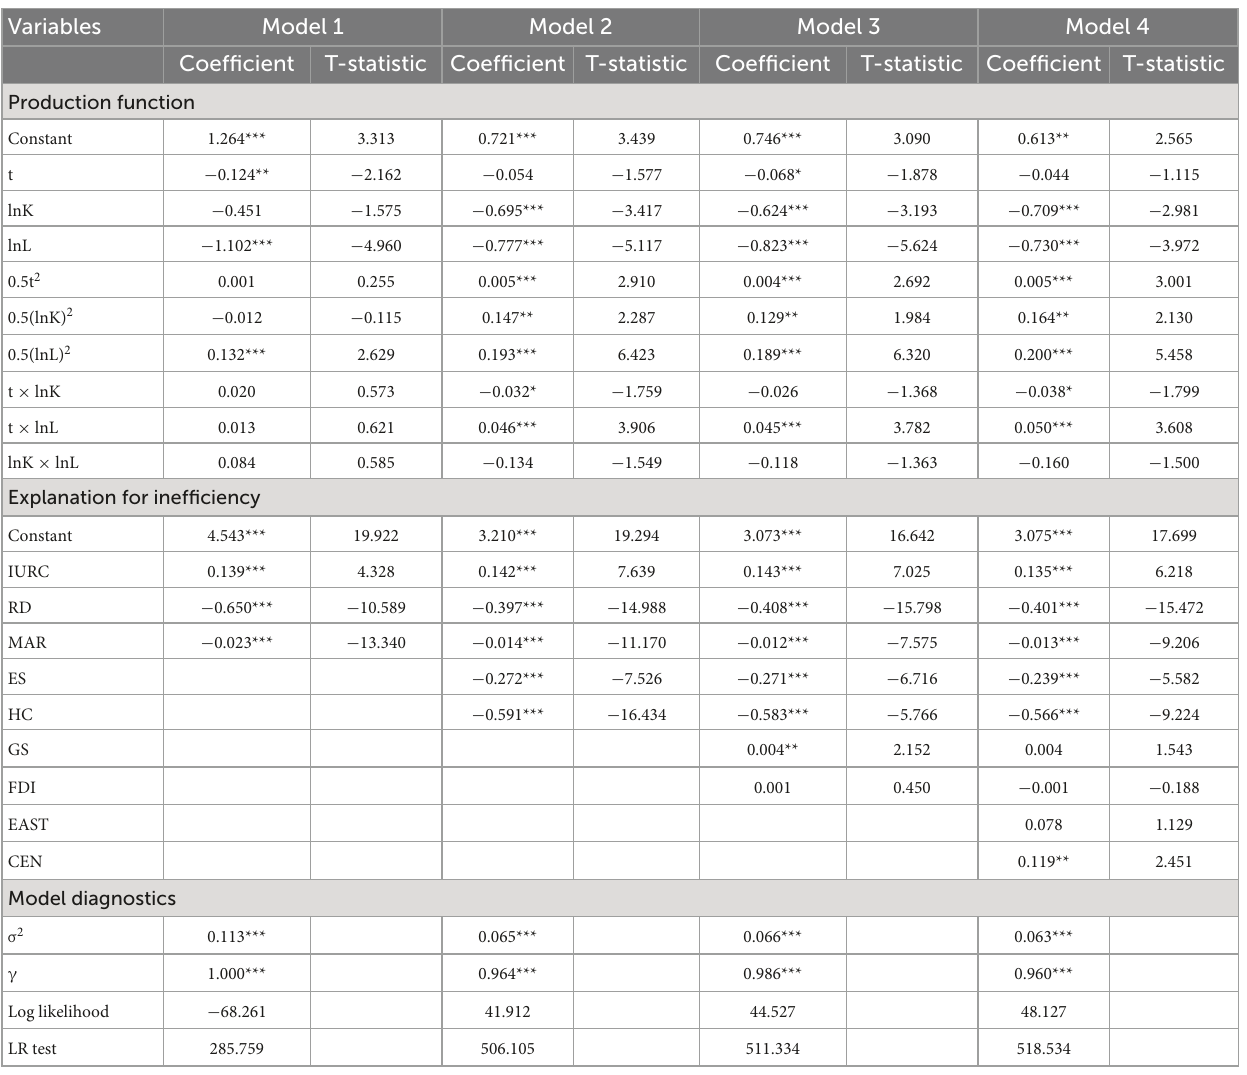
TABLE 6 Estimates of the direct effect of